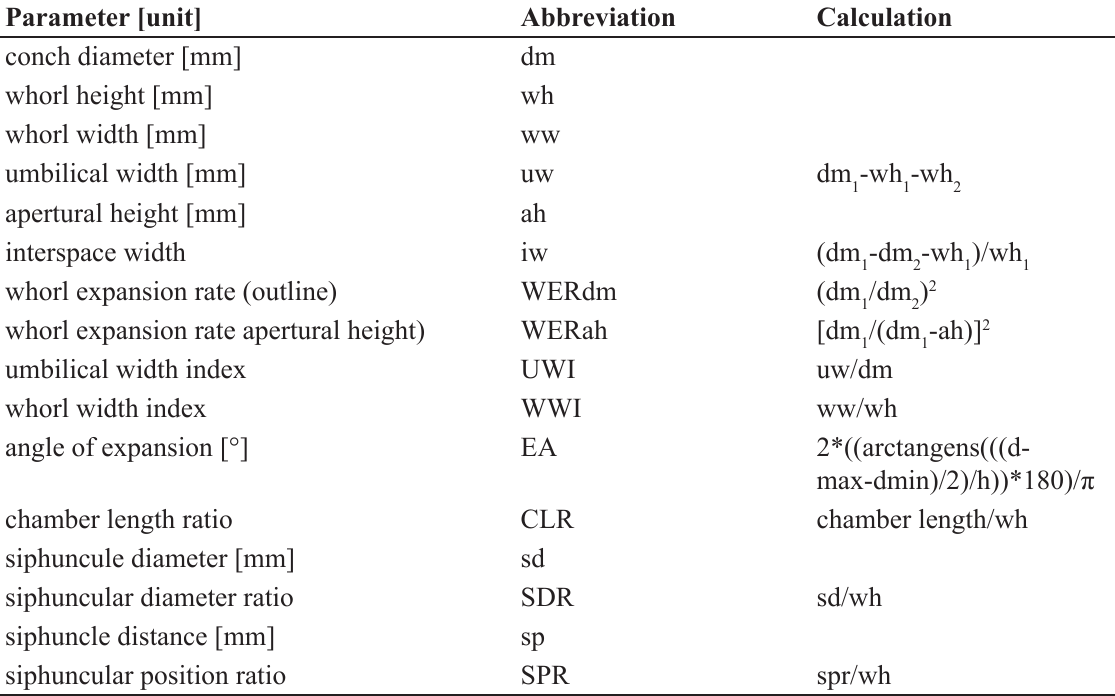
Table 1. Terminology for the description of the specimens of lituitid cephalopods. Parameter [unit]